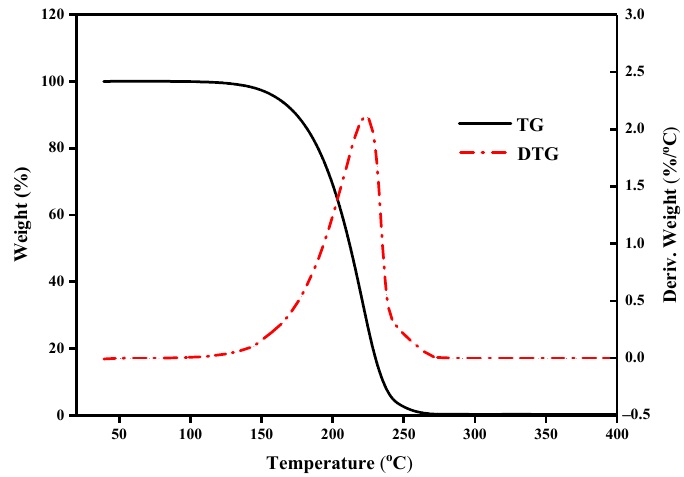
Figure 5. TGA curves of the binary eutectic mixtures LA ‐ MA.